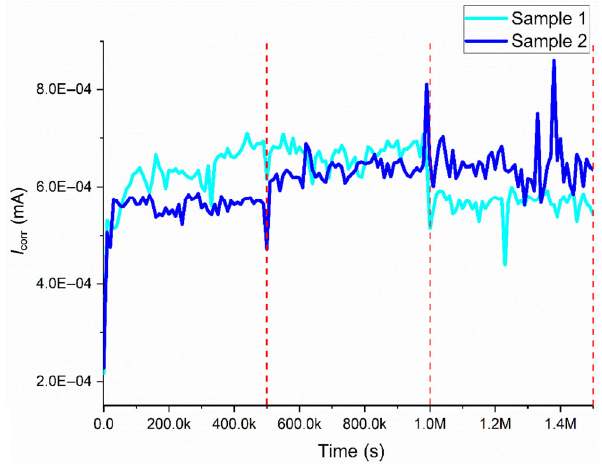
Fig. 3 Variations of